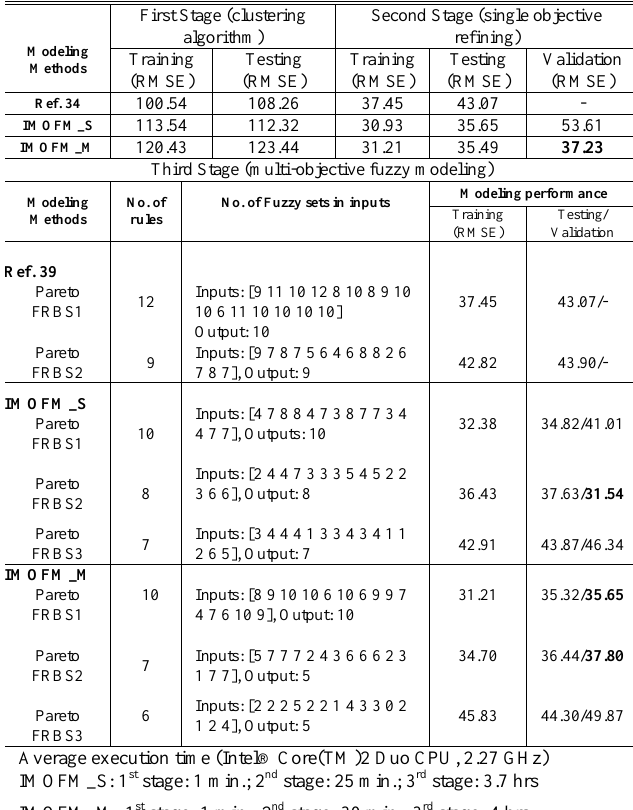
Table 4. Comparisons of the predictive performance of different modeling methods using UTS